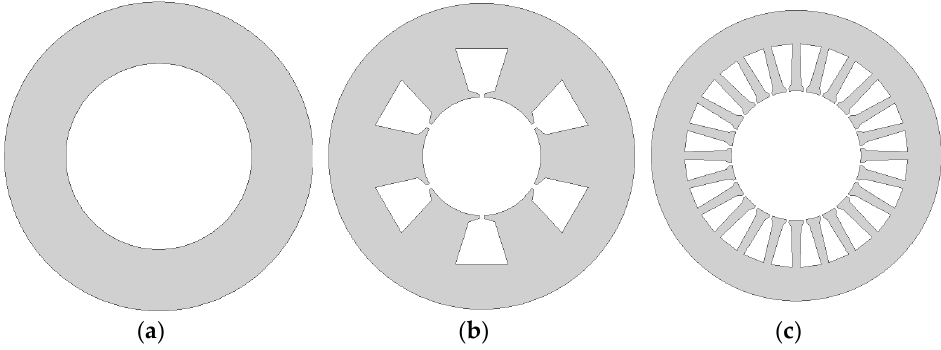
Figure 4. Stator structures of HSPMMs. ( a ) Slotless structure; ( b ) less slot structure; ( c ) multi slot structure.